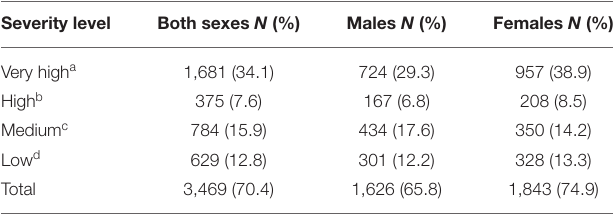
TABLE 4 | “Garbage codes” classified according to four severity levels among out-of-hospital deaths in the VA